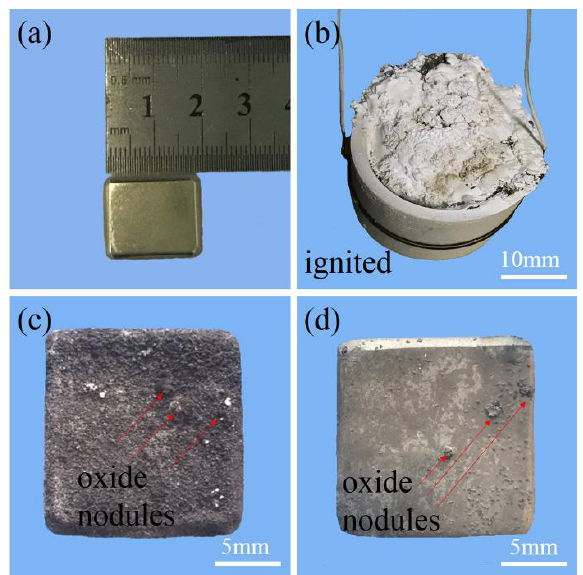
Figure 8. The size ( a ) of sample for test, and macroscopic images of alloys after multi-stage oxidation in air: ( b ) AZ80-ignited, ( c ) AZX801, ( d ) AZX802.The macroscopic images of alloys after oxidized indicate that the addition of Ca can improve oxidation resistance of AZ80 remarkably and the more Ca content the better oxidation resistance.